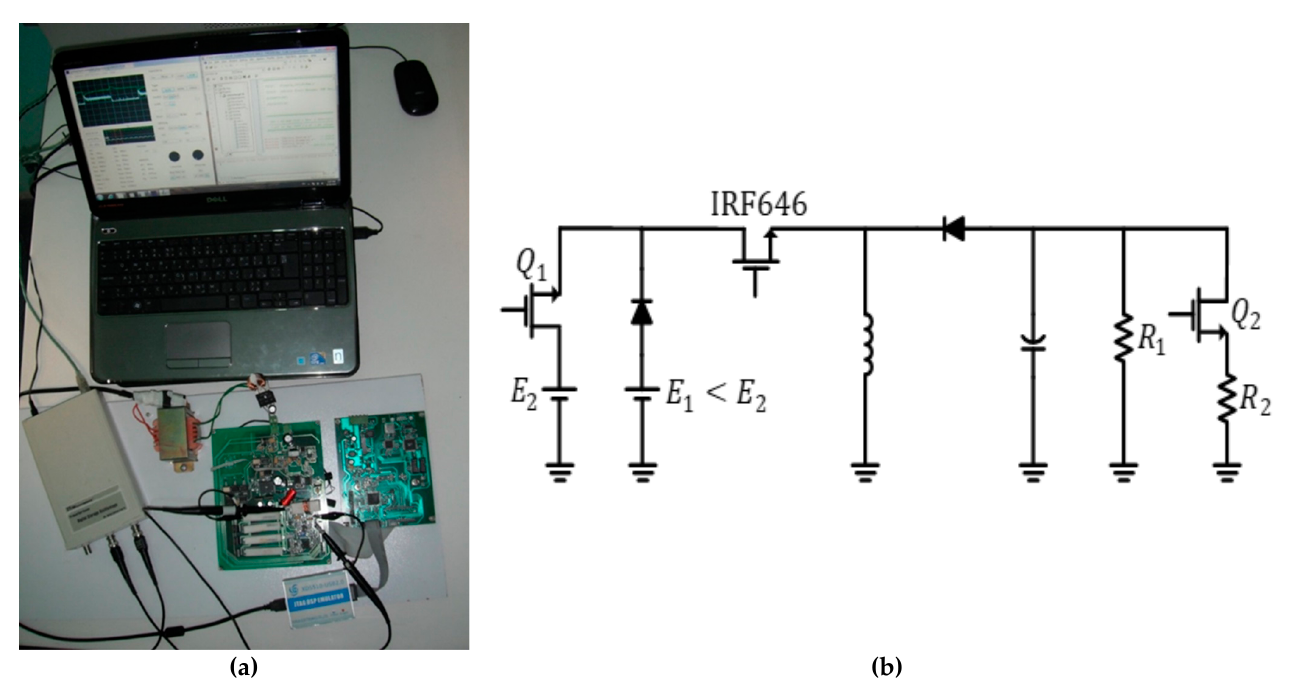
Figure 4. The implemented power circuit. ( a ) The implemented converter. ( b ) Buck/boost DC-DC